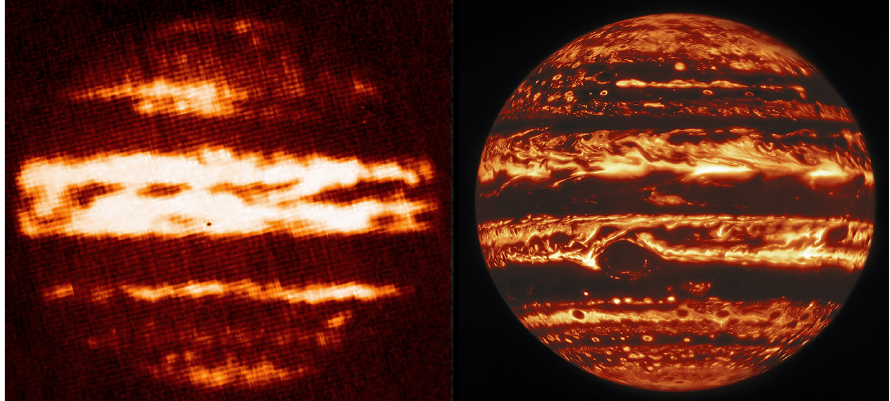
Figure 4. Images of Jupiter at roughly 5 µ m. Brighter regions indicate strong thermal radiation emerg- ing from the atmosphere below the clouds, while darker patches reveal opaque clouds, silhouetted by underlying thermal emission. The image on the left is one of the earliest examples of 5- µ m imaging, made with the Hale 200-in (5-m) telescope at Palomar Observatory in 1973 [83]. The 4.7- µ m image on the right is from the Near-InfraRed Imager (NIRI) instrument [98] at Gemini North in Hawai’i, composed of multiple images captured in 2017 [99]. The images reveal the dramatic improvement in the imaging quality, as well as changes in cloud structure over the past